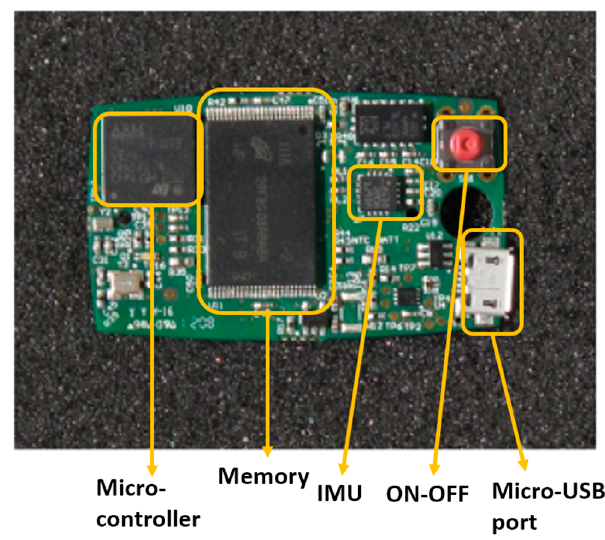
Figure 1. Electronic board of a wearable sensor with an inertial measurement unit (IMU).